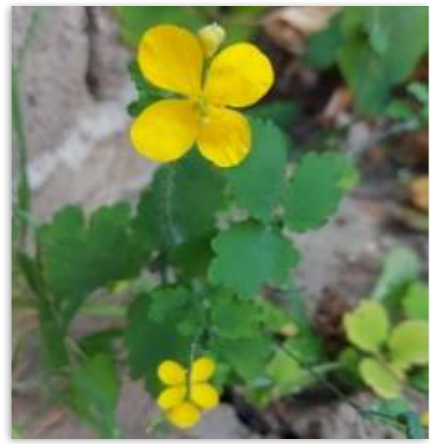
Figure 2. Celandine ( C. majus L.).